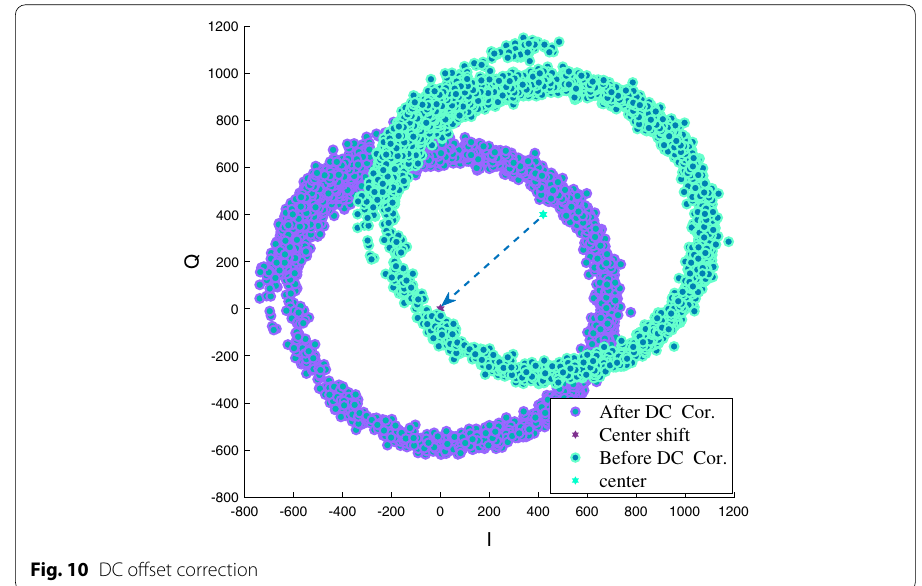
Fig. 10 DC offset correction